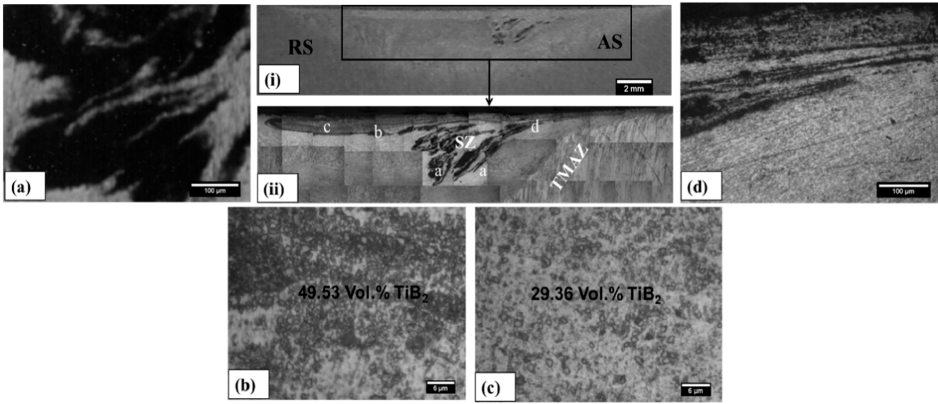
10 of 15 Figure 7. ( i ) Macro-image of cross-section of Sample 1. ( ii ) Microstructure of cross-section of the rectangle in macro-image showing: ( a ) agglomerated region; ( b ) mixed region; ( c ) dispersed region; and ( d ) composite and BM interface. In this research work the processing was performed in position control mode and the plunge for kept constant. At a fixed plunge and considering the frictional characteristics for work and tool material combination to remain constant, the heat input during processing would largely depend on